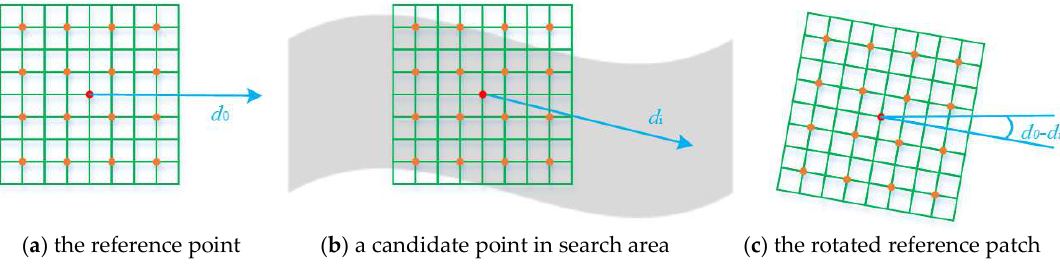
Figure 7. The computation of the accelerated SIFT descriptor. In ( a ), a SIFT point is described by 16 8-D vectors, which can be stored in the 16 orange points. Therefore, for every pixel in search area ( b ) we can calculate and store the 8-D vectors only once. When a point is to be matched, its SIFT descriptor is easily retrieved. In ( c ) the reference descriptor is rotated according to the difference of the two epipolar directions.